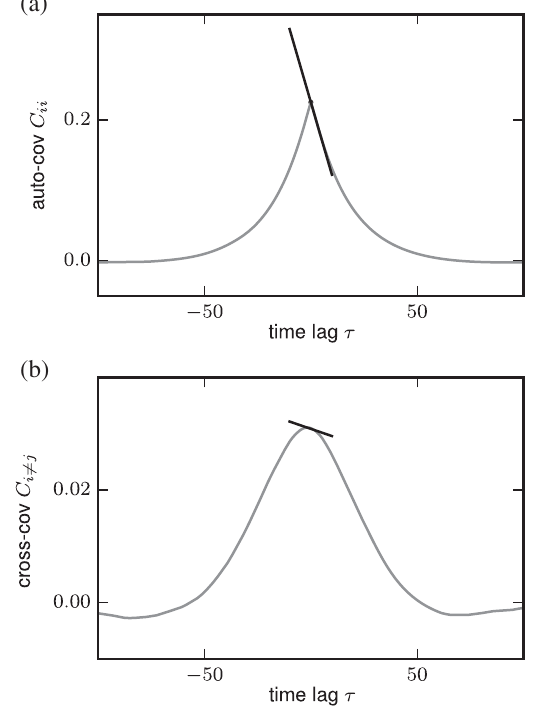
FIG. 7. Autocovariance and cross-covariance functions. Example of an autocovariance function (a) and a cross-covariance function (b) in the network described in Fig. 1. The respective slopes of the functions at time lag 0 þ are indicated by the black tangent